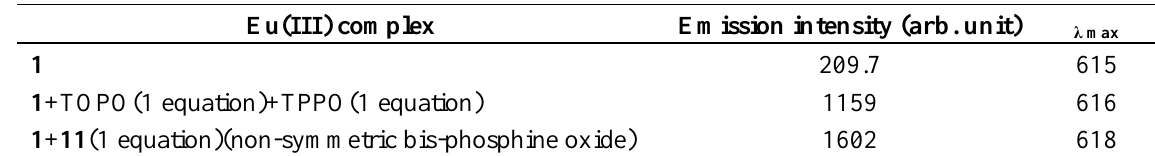
Table 6. Comparison of the spectra intensities of Eu(III) complexes containing non- symmetric bis-phosphine oxide with that of Eu(II) containing two different phosphine oxides (measured in 2,3-dihydrodecafluoropentane at 2 × 10  4 M).